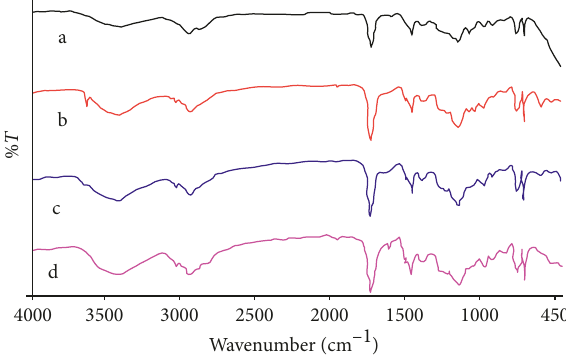
Figure 2: FT-IR spectra of (a) poly(DEAMSt0.49-co-BMA), (b) poly(DEAMSt0.49-co-BMA)-Co, (c) poly(DEAMSt0.49-co-BMA)- Ni, and (d) poly(DEAMSt0.49-co-BMA)-Zn.